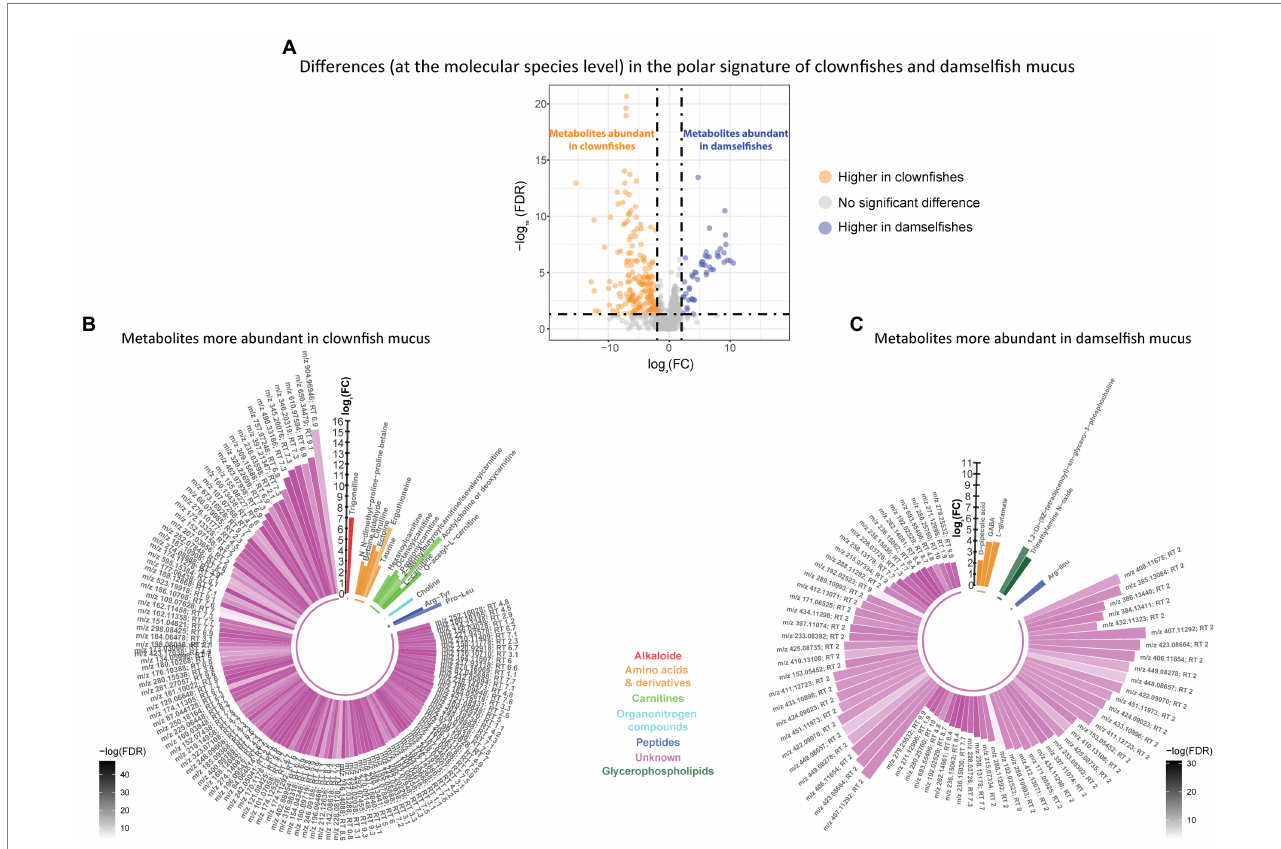
FIGURE 4 (A) Volcano plot of the global polar metabolome detected in the fish individuals. The log 2 (Fold change) limited at − 2 and 2 highlights the polar metabolite features higher in clownfishes (orange) and the metabolite features higher in damselfishes (purple). These features are subsequently represented in circular bar plots (B) and (C) to highlight the identified metabolite features and classes differing between these two fish groups. Each colour represents a polar metabolite class and the different shades of one colour reflect the -log(FDR) of each lipid, calculated by performing a t